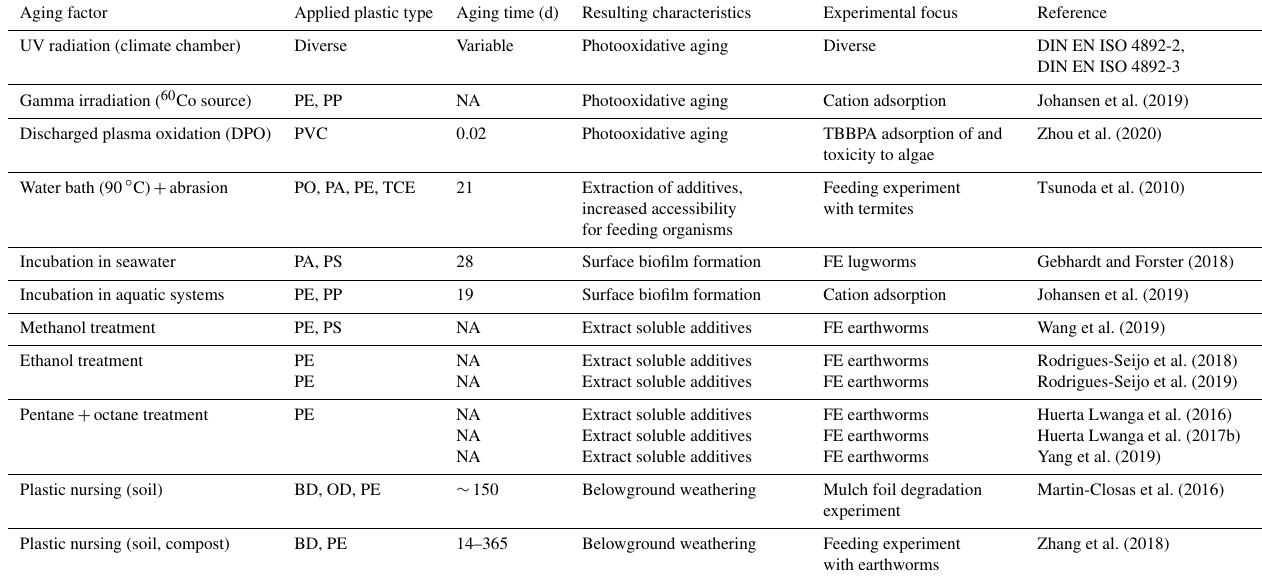
Table 2. Approaches of surface (pre-)weathering in recent experiments with soil microplastic. The abbreviations used in this table are as follows: UV – ultraviolet; TBBPA – tetrabromobisphenol A; FE – feeding experiment; BD – biodegradable plastic; OP – oxo-degradable plas- tic, PA – polyamide; PE – polyethylene; PO – polyolefin; PP – polypropylene; PVC – polyvinyl chloride; TCE – thermoplastic copolyester elastomer. NA denotes that information was not